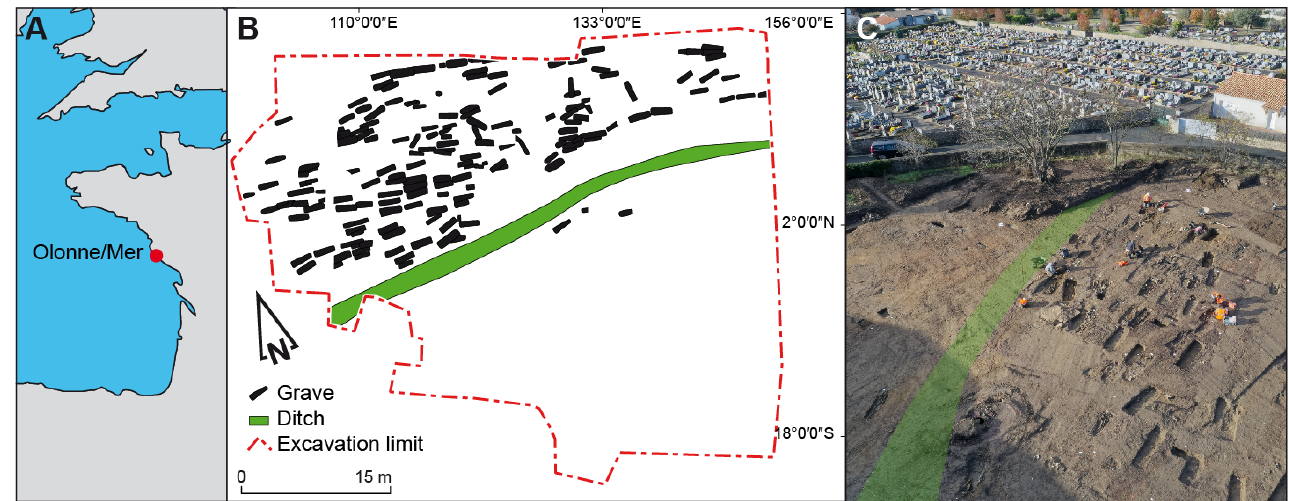
Figure 1. ( A ) Location of the French city of Olonne-sur-Mer; ( B ) Location of the graves and the ditch at the south; ( C ) Drone photography of the digging site.